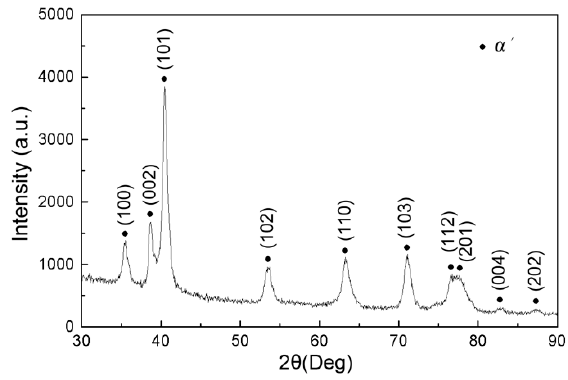
Figure 7. XRD pattern of Ti6Al4V deposited coating.